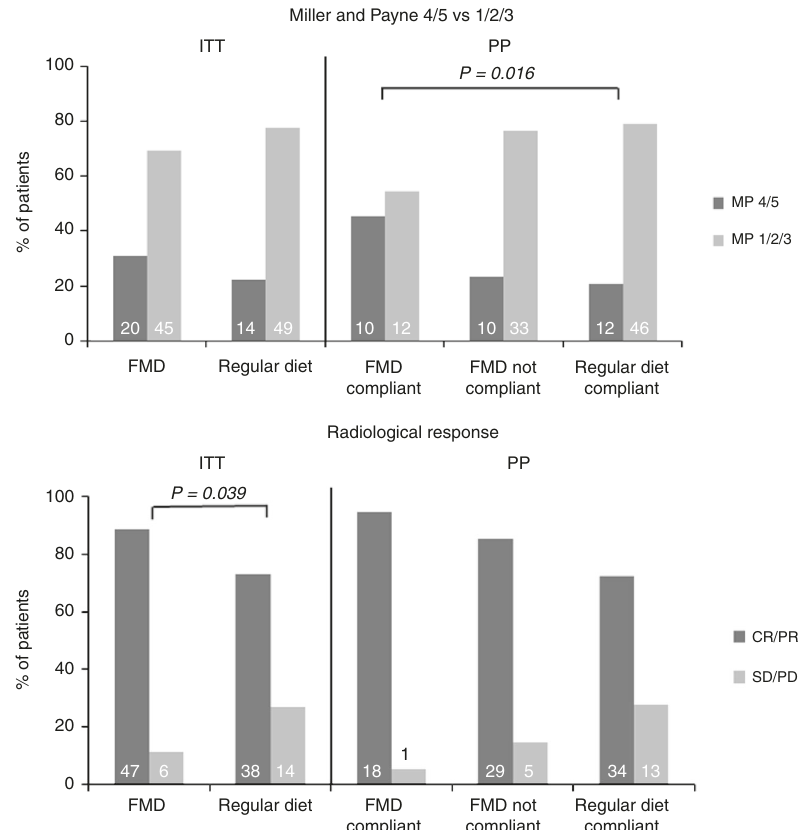
Fig. 2 Tumor response data for the ITT and PP analysis. The pathological response was given for Miller and Payne pathological response score 4/5 (90 – 100% tumor cell loss) vs. 1/2/3 (less than 90% tumor cell loss). The radiological response was scored according RECIST 1.1 and given for complete response + partial response vs. stable disease + progression disease. Abbreviations: FMD: fasting mimicking diet, ITT: Intention to treat, PP: Per protocol, MP: Miller and Payne, CR: complete response, PR: partial response, SD: stable disease, PD: progression disease. Logistic regression was used (2-sided). Source data are provided as a Source Data fi